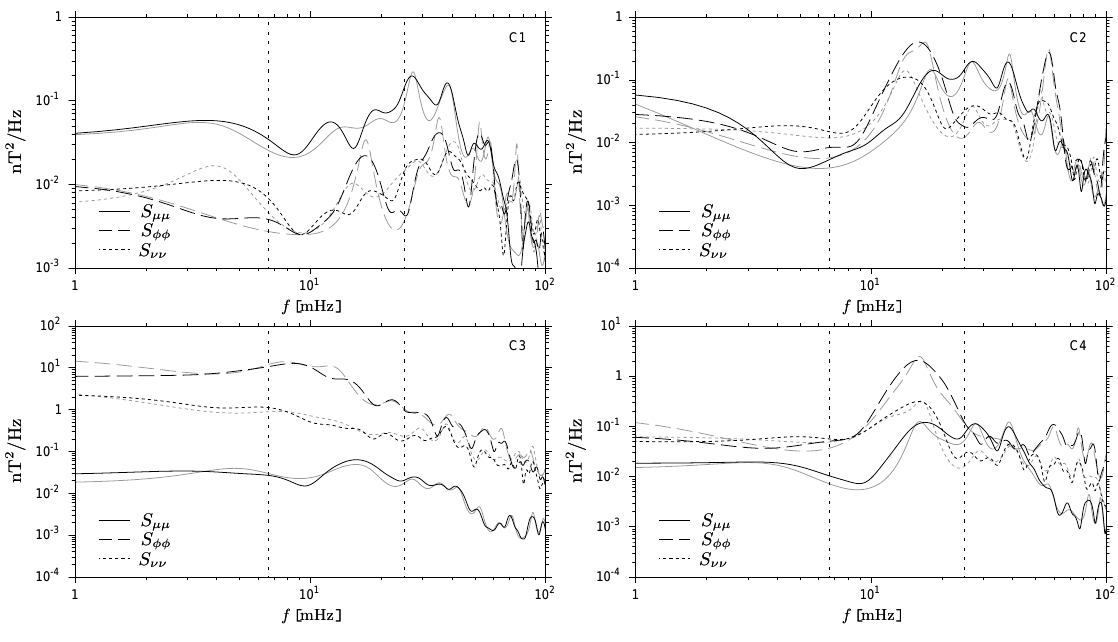
Fig. 6: Power spectral densities of the magnetic field components for the interval 18:00 to 18:25 UTC on 21 January 2003. The black curves correspond to the PSD calculated using Welch’s method, while the grey curves were obtained using the MEM. The Pi2 band (6.7–25.0mHz) is enclosed between the vertical dashed lines.